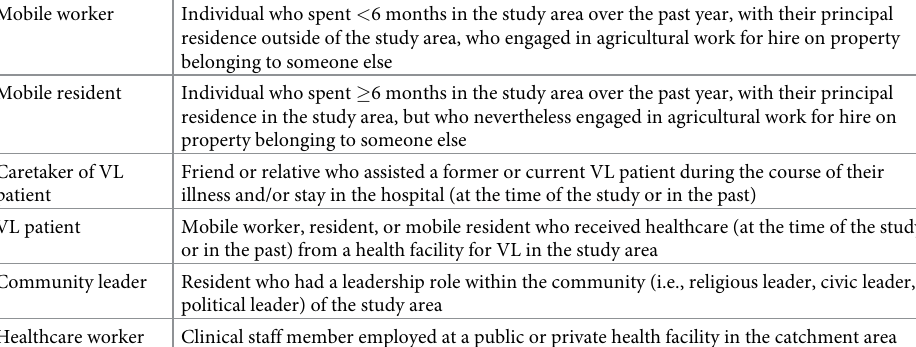
Table 1. Study definitions used for participant categories. Mobile